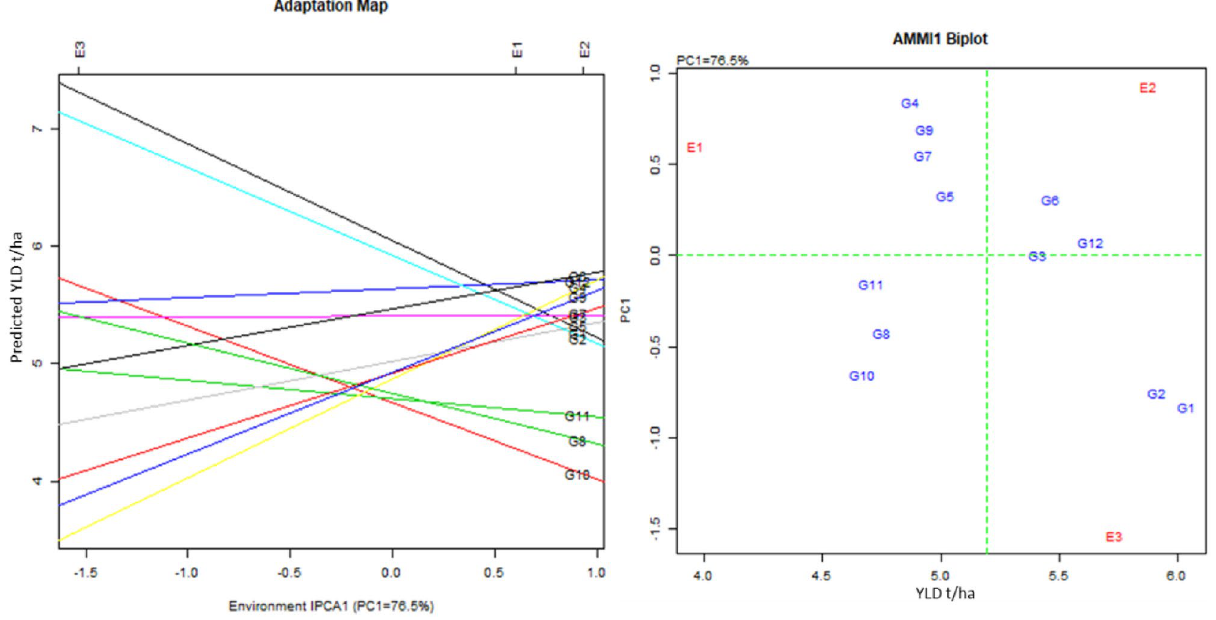
Figure 6. Adaption map and AMMI biplot. IR144480-2-2-5 (G1), IR144483-1-2-4 (G2), IR144484-1-2-2 (G3), IR144484-1-2-5 (G4), IR144485-1-1-6 (G5), IR144488-2-1-4 (G6), IR144489-1-1-1 (G7), IR144491-1-1-1 (G8), IR144491-1-2-5 (G9), IR144491-1-2-6 (G10), Matatag 1 (G11), BRRI dhan71 (G12), CL (E1), GP (E2) and HG